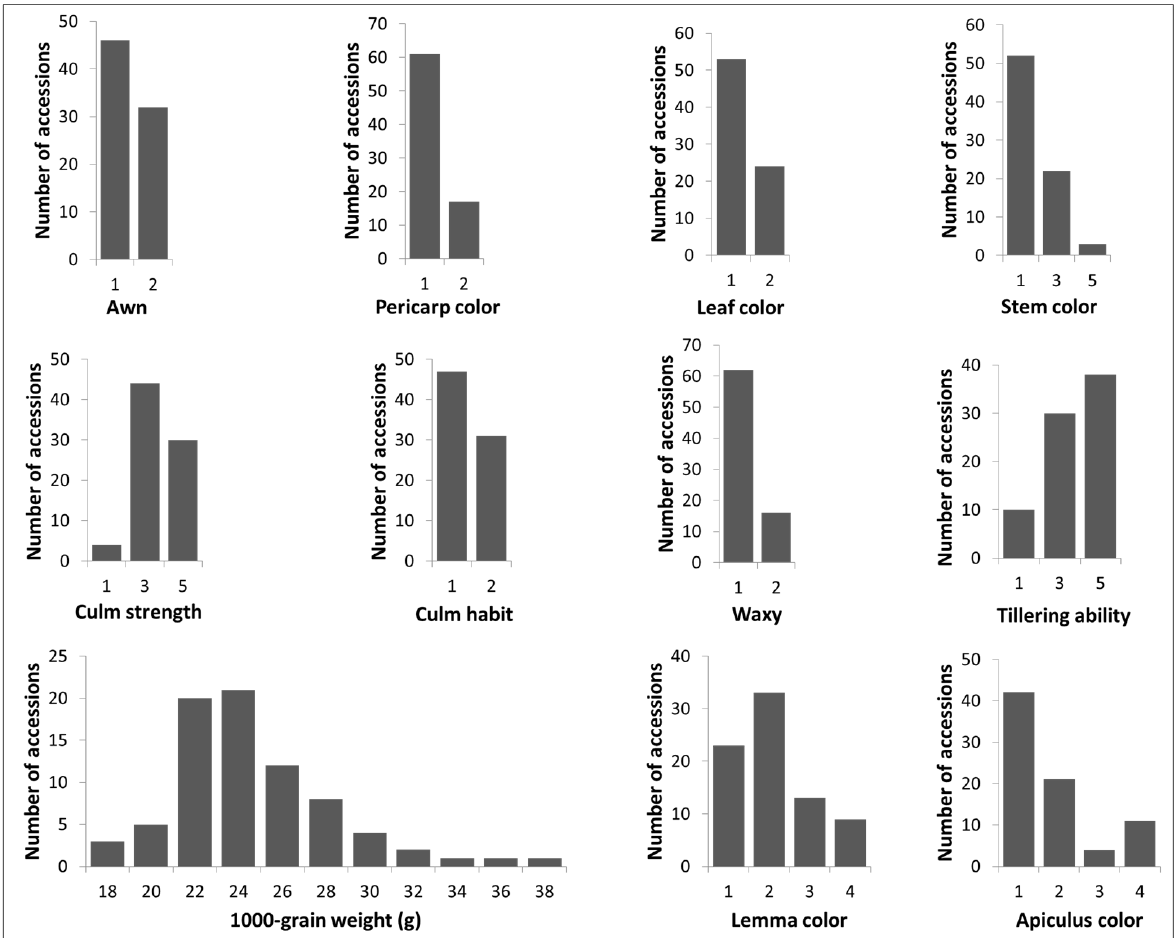
Figure 2. Phenotypic variation of the 11 agro-morphological traits in Vietnamese rice landraces.